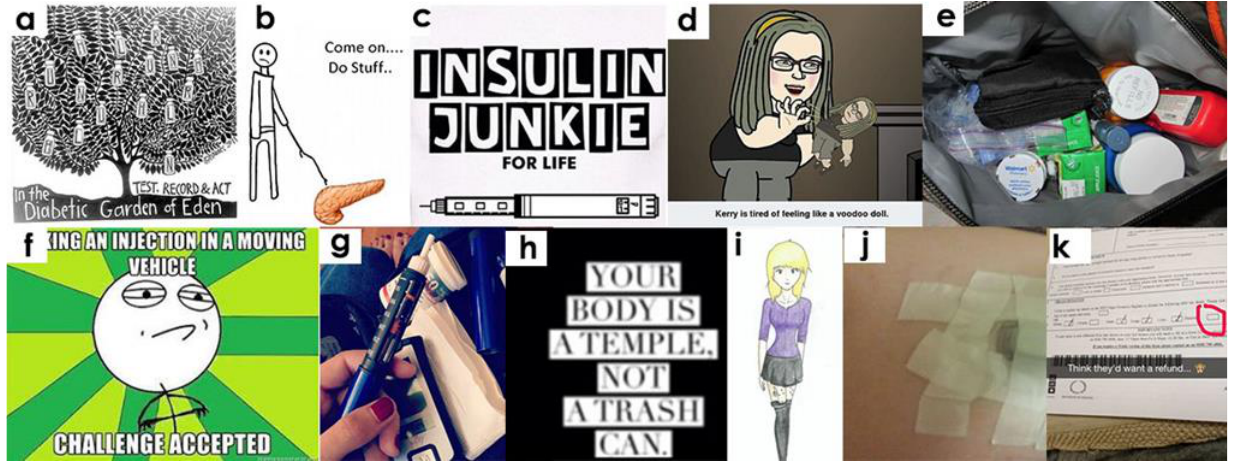
Figure 4. Images related to the self-reflection on diabetes.